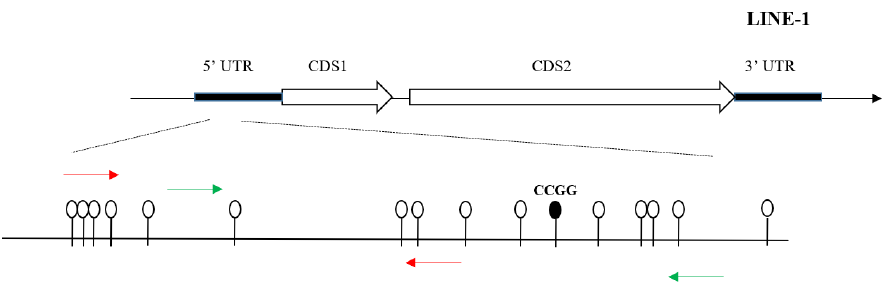
Figure 1. Schematic representation of location of the CCGG loci in the 5UTR of LINE-1. The red line indicates the region where enrichment of BPA-associated 5hmc was detected through high-throughput sequencing, and it is 200-bp long in LINE-1. The green line represents the location of qPCR product.